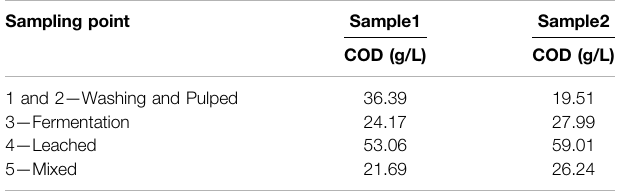
TABLE 2 | COD analysis results of the wastewater samples from the Coffee Wet Processing Plant. Sampling